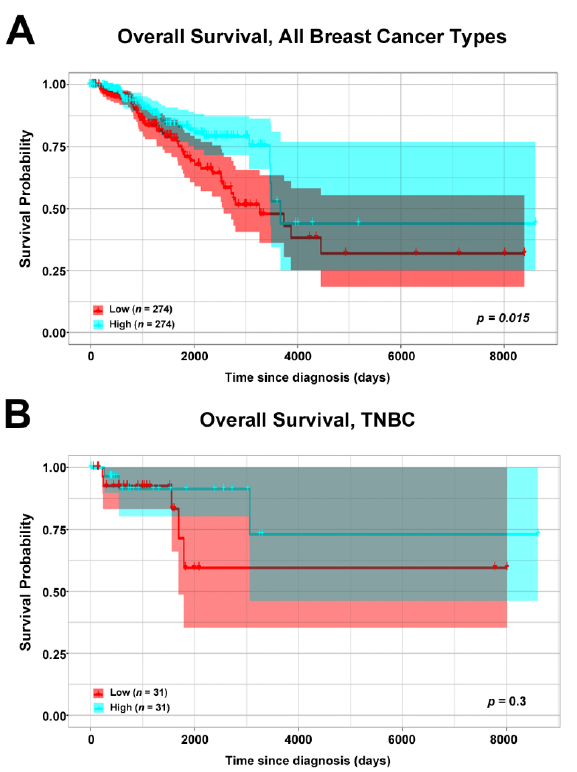
Figure 2. Estrogen receptor beta (ER β ) mRNA expression and survival of breast cancer patients from The Cancer Genome Atlas (TCGA) cohort [25]. Kaplan–Meier curves of overall survival for breast cancer (BC) ( A ) and TNBC ( B ) patients with respect to ER β mRNA expression level (low expression: values below the first quartile, high expression: values above the third quartile). The highlighted area indicates confidence